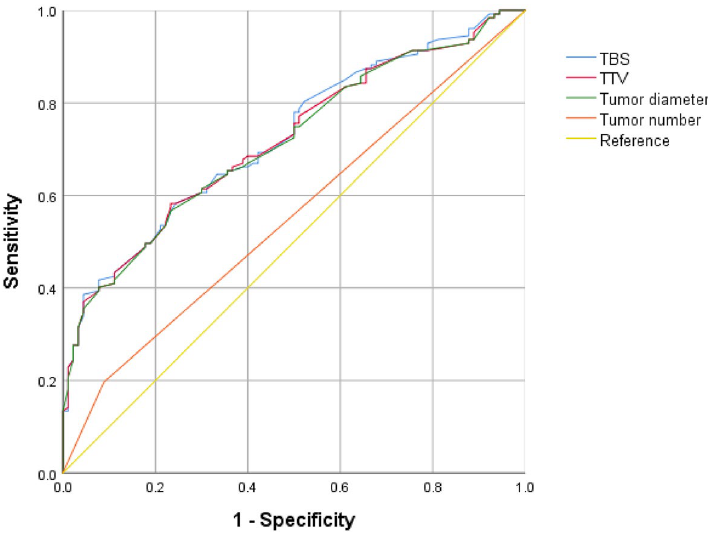
Figure 3. Comparison of TBS, TTV, tumor diameter and tumor number in predicting